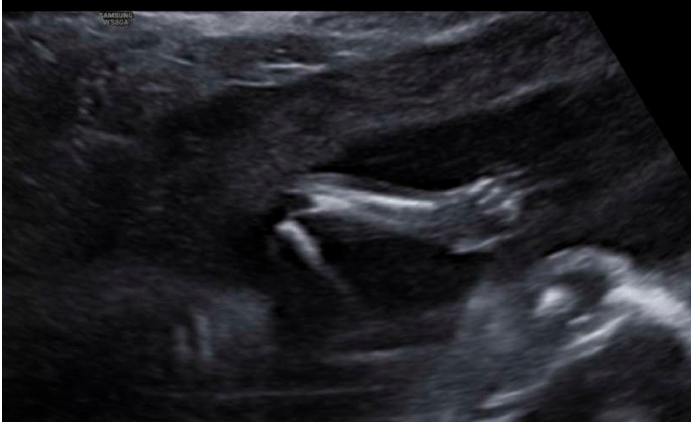
Figure 9. Wrist joint seemed fixed and feet located in hyperflexion with little mobility.